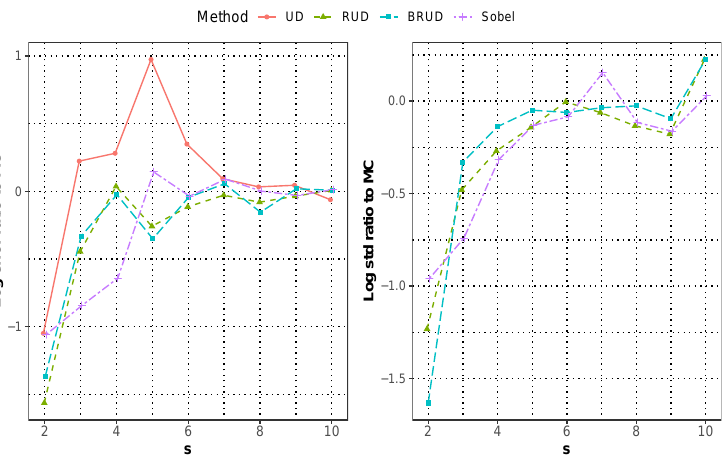
Figure 3. The median approximation error of integration 2 over all runs for dimension s ≤ 20.